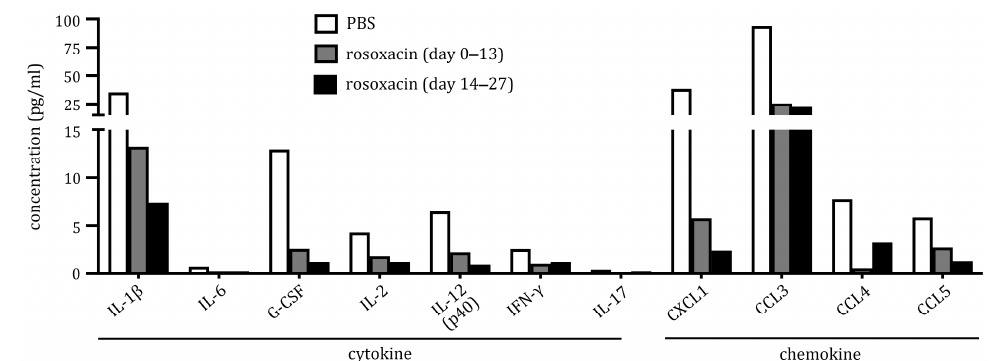
Figure 4. Rosoxacin reduced secretions of cytokines and chemokines from lymphocytes. Lymphocytes isolated from deep cervical lymph nodes of EAH mice that received different treatments were cultured for 96 h. The levels of cytokines and chemokines secreted by lymph node cells were determined by a multiplex cytokine assay. Shown are cytokines/chemokines whose expression levels were modulated by rosoxacin treatments.